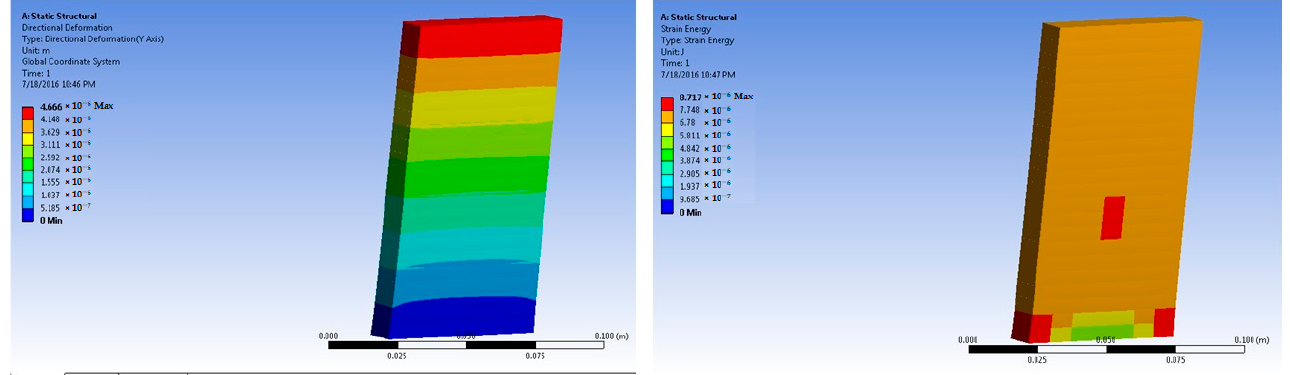
Figure 16. Two percent basalt-fiber-reinforced concrete slab at 500 × 10 5 N force (deformation and strain energy).